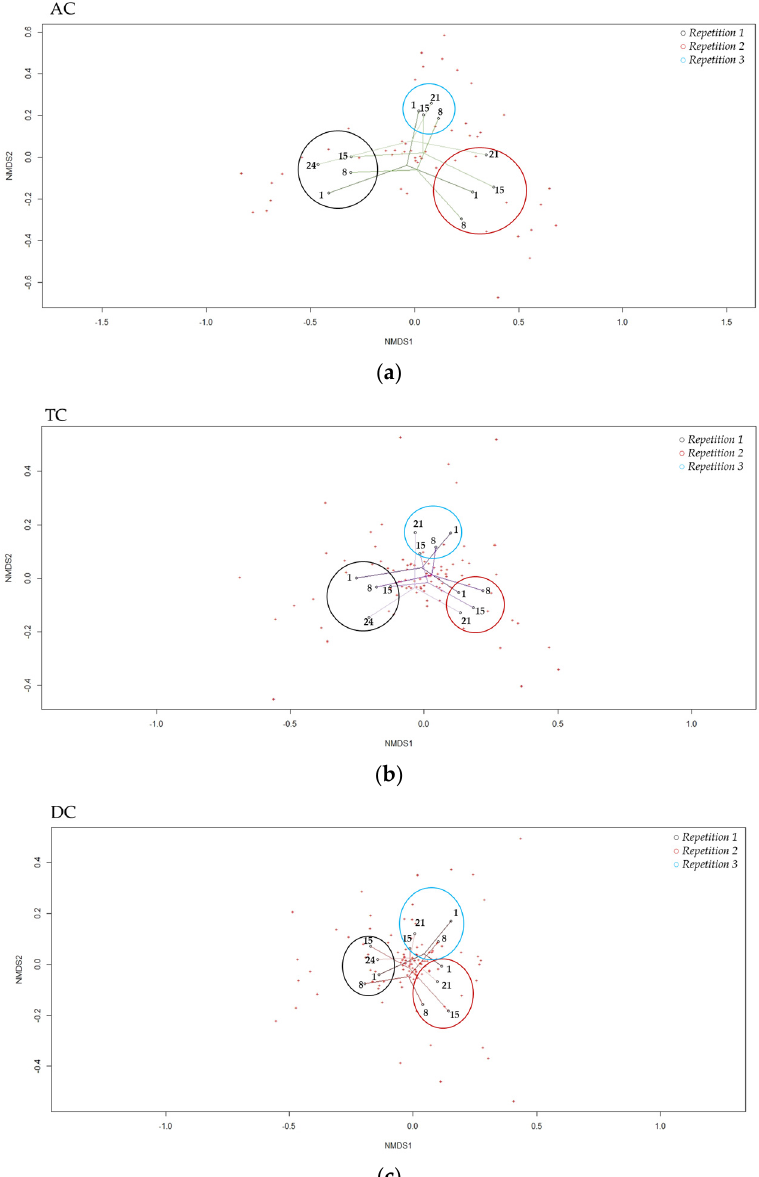
Figure 7. “Non-Metric Multidimensional Scaling”, NMDS, of β -diversity the in ascending ( a ), transverse ( b ) and descending ( c ) colons assessed by 16S rRNA Illumina Sequencing after one daily ULIP33 phage injection (10 mL at 10 9 PFU/mL) in the ascending colon for 7 days. Black circle: repetition 1; burgundy circle: repetition 2 and light blue circle: repetition 3.